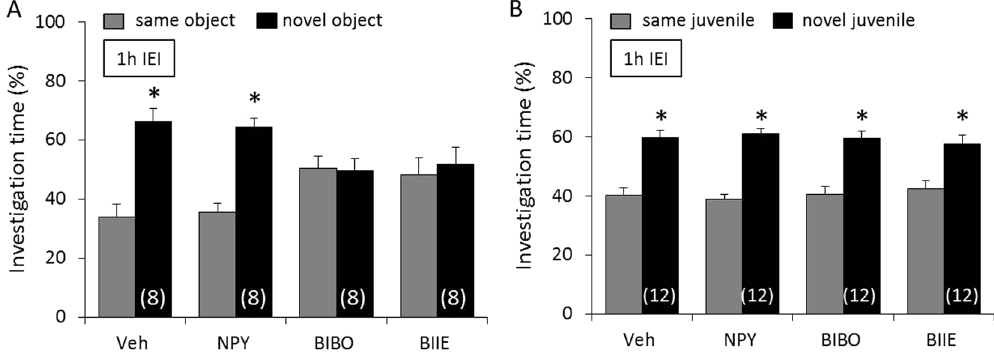
Figure 5. Y1 and Y2 receptor-mediated neuropeptide Y (NPY) neurotransmission is necessary for non-social, but not social, memory consolidation. Mice were infused icv with either vehicle (Veh; 2 µ l), NPY (1 nmol/2 µ l), BIBO (2 nmol/2 µ l), or BIIE (2 nmol/2 µ l) immediately after the acquisition period of the object ( A ) and social ( B ) discrimination test, respectively. Intact memory and discrimination abilities are reflected by an increased investigation of the novel versus the same stimulus after an inter-exposure interval (IEI) of 1 h. Data represent means + SEM, and numbers in parentheses indicate group sizes. * p < 0.05 versus same stimulus.